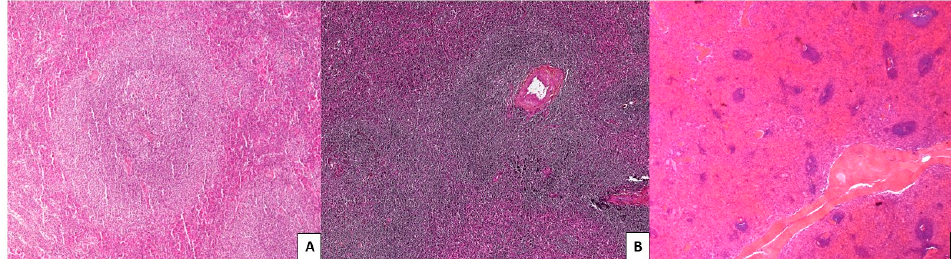
Figure 1. Histological patterns of splenic marginal zone lymphoma (SMZL; magnification: ×10). ( A ) Biphasic pattern: small lymphocytes surround and replace the white pulp follicles and merge with a peripheral zone of larger marginal zone (MZ)-like cells, including scattered transformed blasts, giving the characteristic biphasic pattern. ( B ) Monophasic pattern: cases lack a central core of smaller lymphocytes and have a monophasic pattern. ( C ) Atrophic pattern, with an atrophic white pulp and few infiltrating cells in the red pulp.